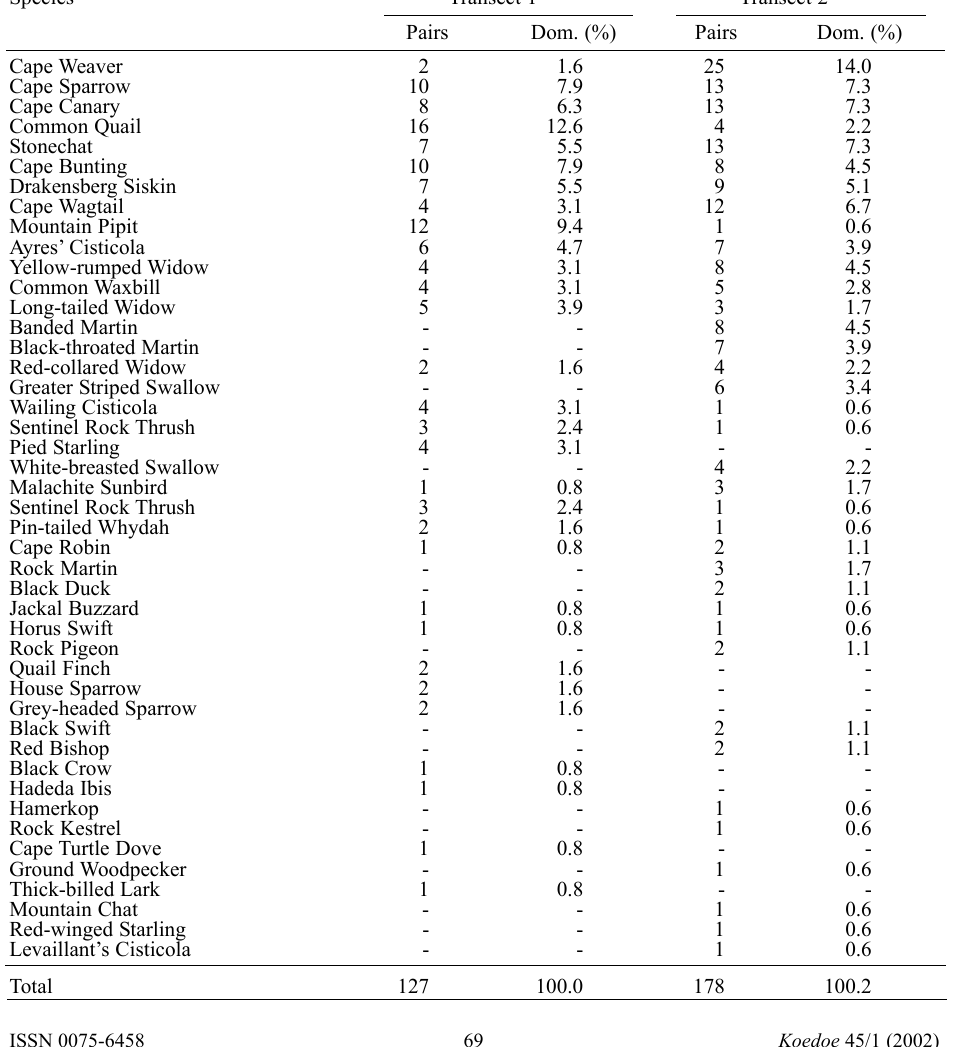
Breeding bird communities in farmland bordering Sehlabathebe National Park in January 2001. Dominant species are given in bold case Species Transect